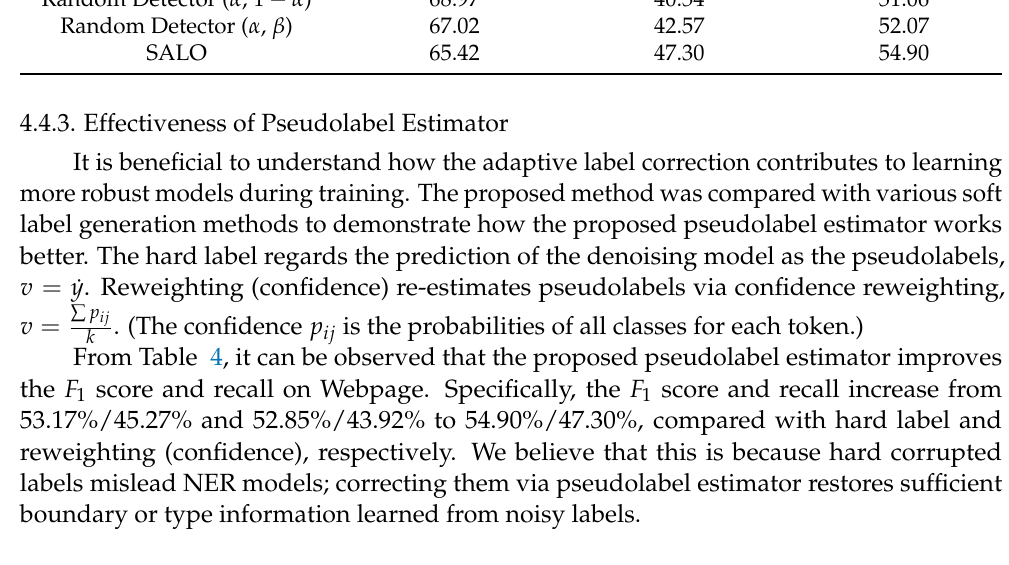
Table 4. The effectiveness of pseudolabel estimator on Webpage: Precision, Recall and F 1 score (in %).